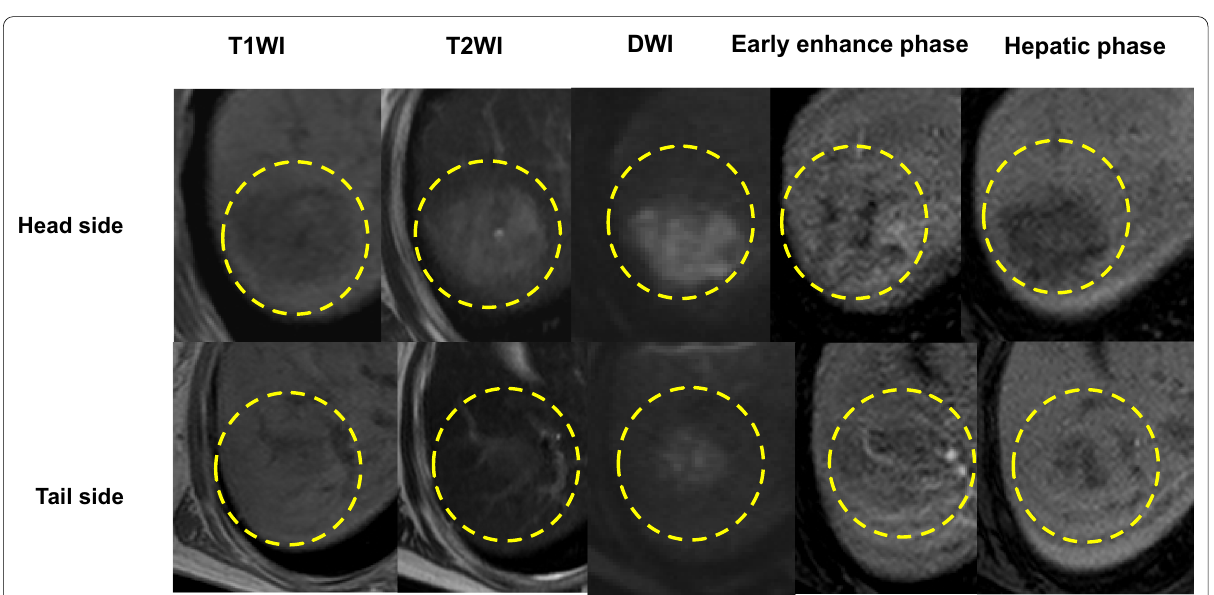
Fig. 3 Magnetic resonance imaging (MRI). MRI revealed a tumor in liver segment 8 with low- to iso-intensity on T1-weighted imaging (T1WI), high- to iso-intensity on T2-weighted imaging (T2WI), high intensity on diffusion-weighted imaging (DWI) and low intensity on hepatocellular images, and the enhanced pattern was the same as that of computed tomography (dotted